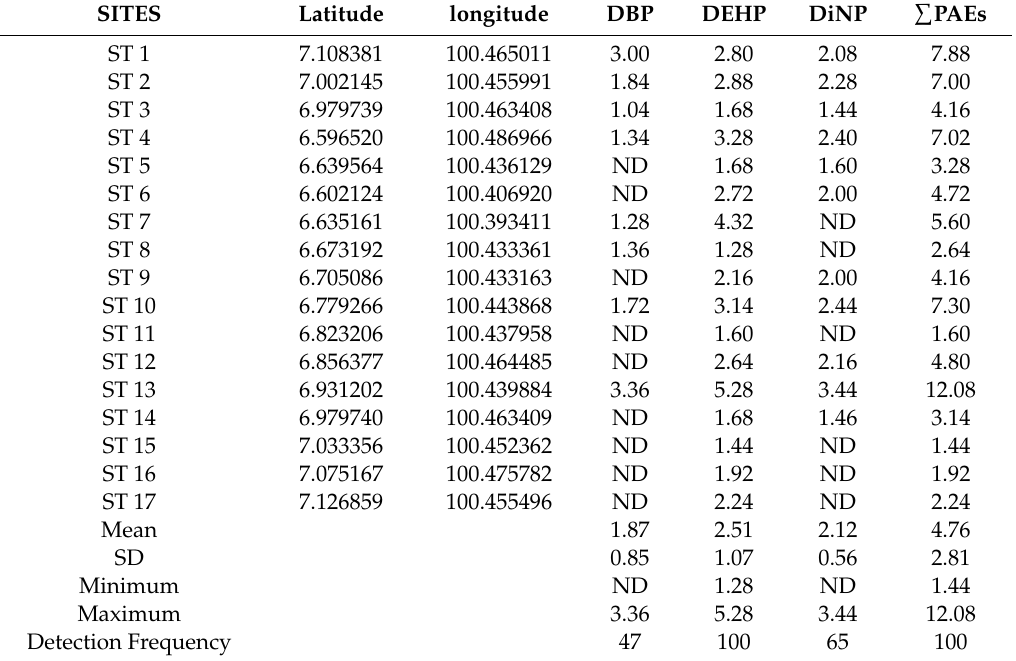
Table 1. The concentration of Phthalate esters (PAEs) in surface water of U-Tapao canal ( µ g / L). SITES